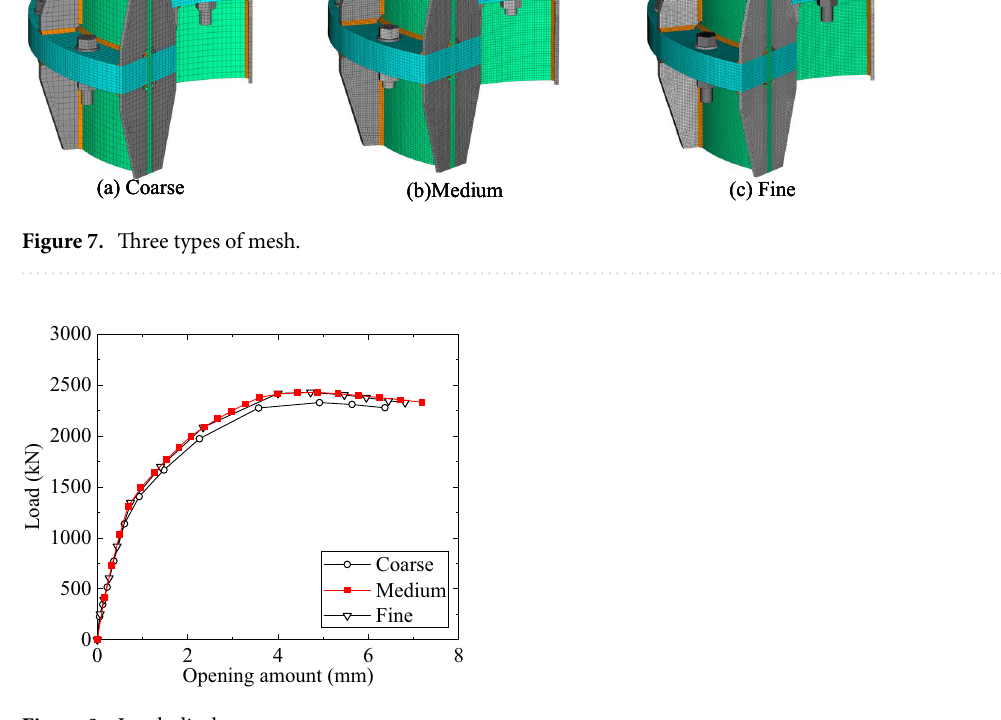
Figure 8. Load–displacement